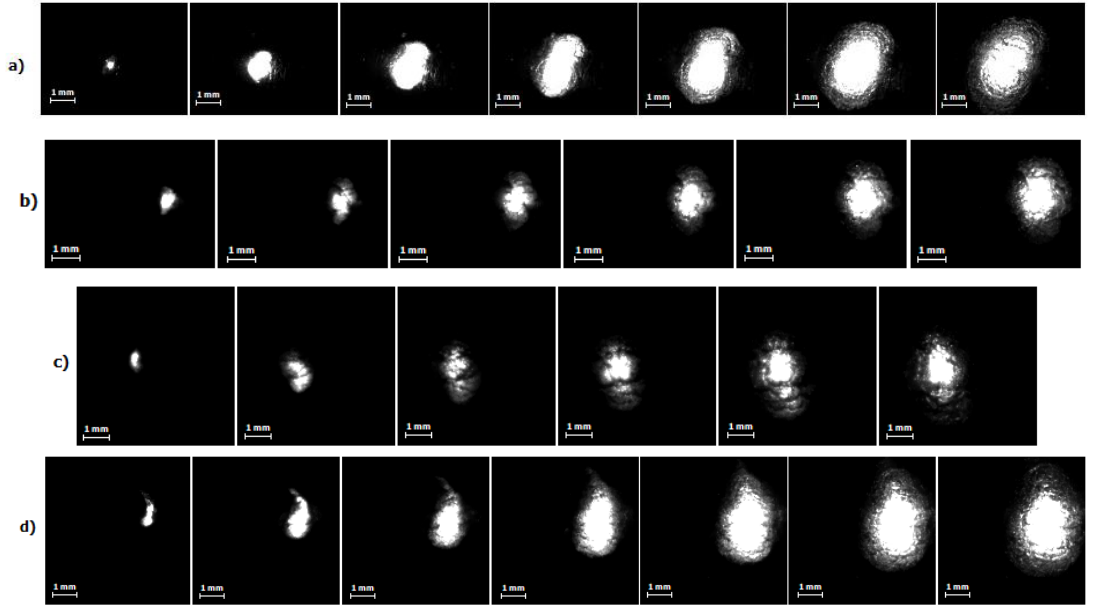
Figure 7. High-speed imaging of the discharge and bubble size development up to the maximal size for different current regimes: ( a ) I = 450 A, time interval between presented frames–60 μs, image resolution–128 × 96 px, frame rate–100,000 fps; ( b ) I = 660 A, time interval between presented frames–60 μs; image resolution–128 × 96 px, frame rate–100,000 fps; ( c ) I = 800 A, time interval between presented frames–65 μs; image resolution–128 × 128 px, frame rate–75,000 fps; ( d ) I = 1000 A, time interval between presented frames–65 μs; image resolution–128 × 128 px, frame rate–75,000 fps.